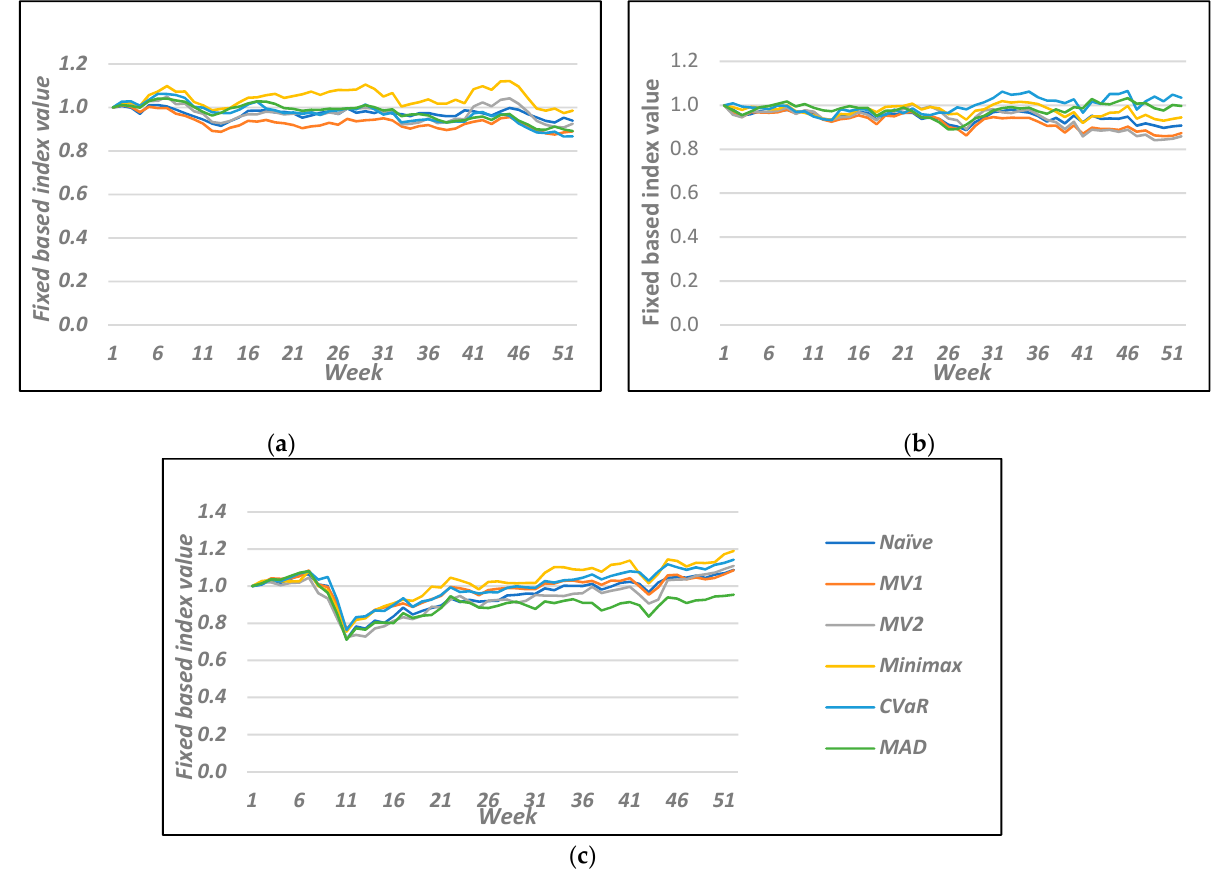
Figure 2. Weekly calculated fixed based index for portfolio value by year for a period of market decline: ( a ) 2007, ( b ) 2008, ( c ) 2020.